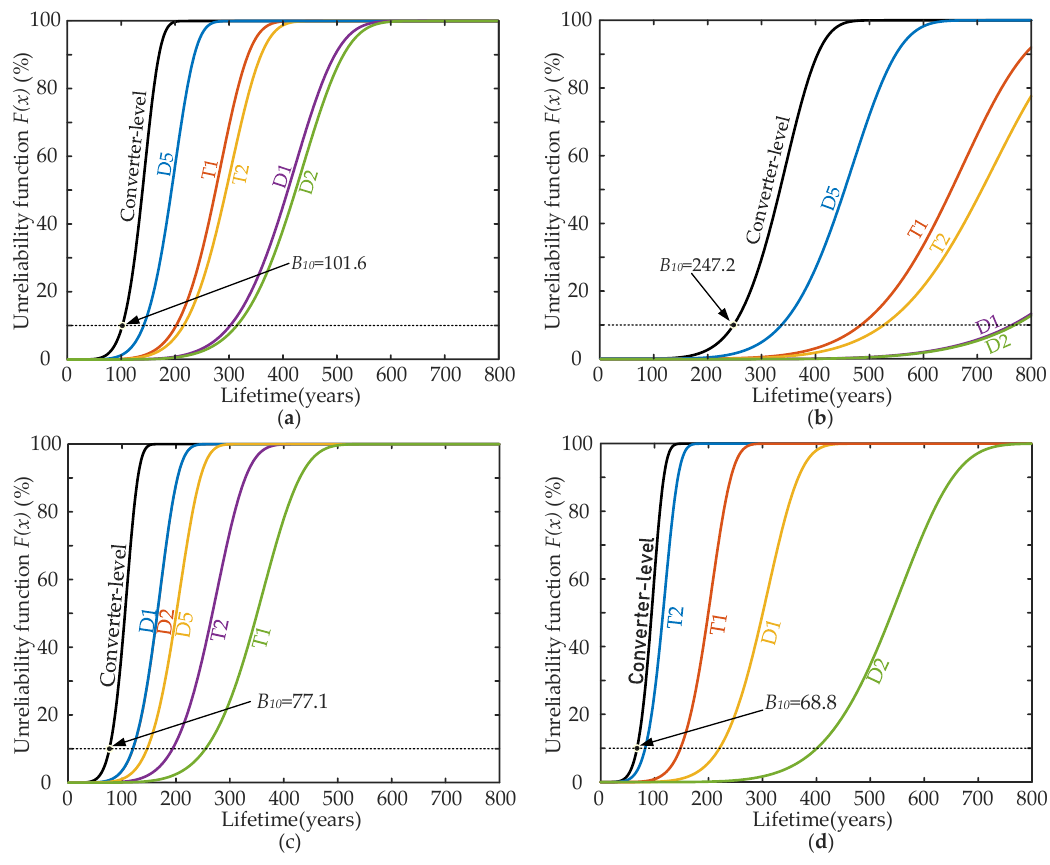
Figure 12. Unreliability functions of the different power converters: ( a ) PV inverter with the AC-coupled BESS, ( b ) PV inverter with the DC-coupled BESS, ( c ) battery inverter for the AC-coupled BESS, and ( d ) battery converter for the DC-coupled